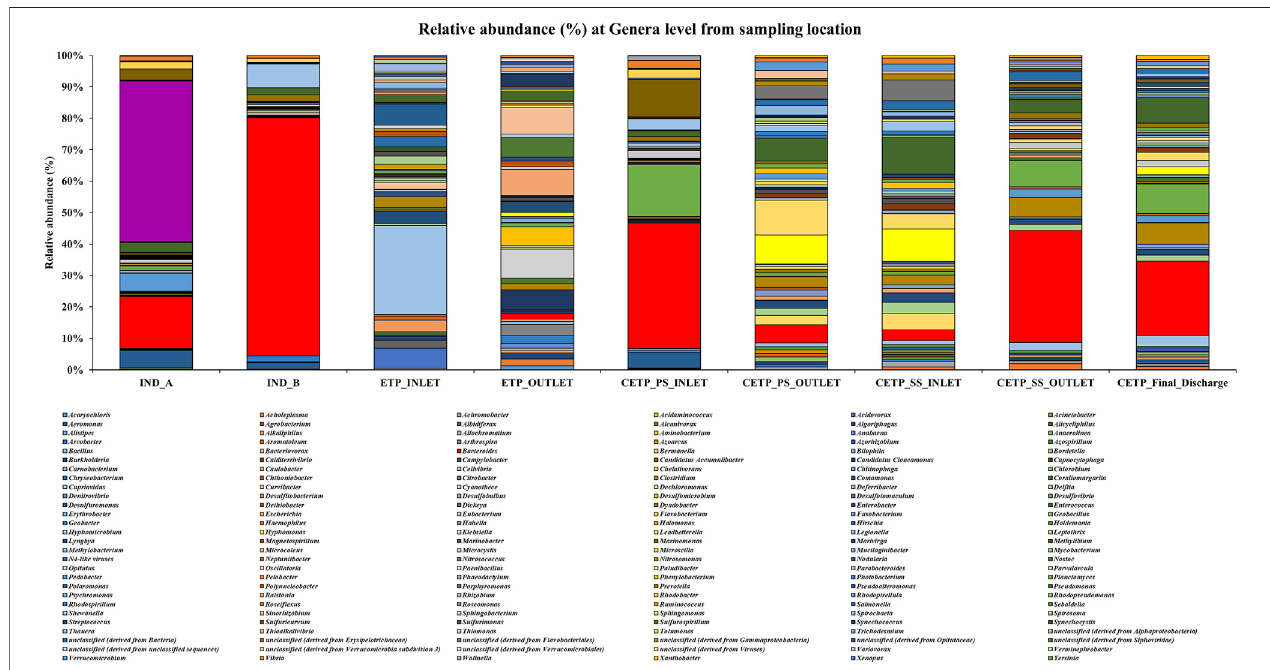
FIGURE 4 | Relative abundance (%) of the genera level in different metagenome samples collected from the textile industry wastewater site, common ef fl uent treatment plant (CETP), and ef fl uent treatment plant (ETP).